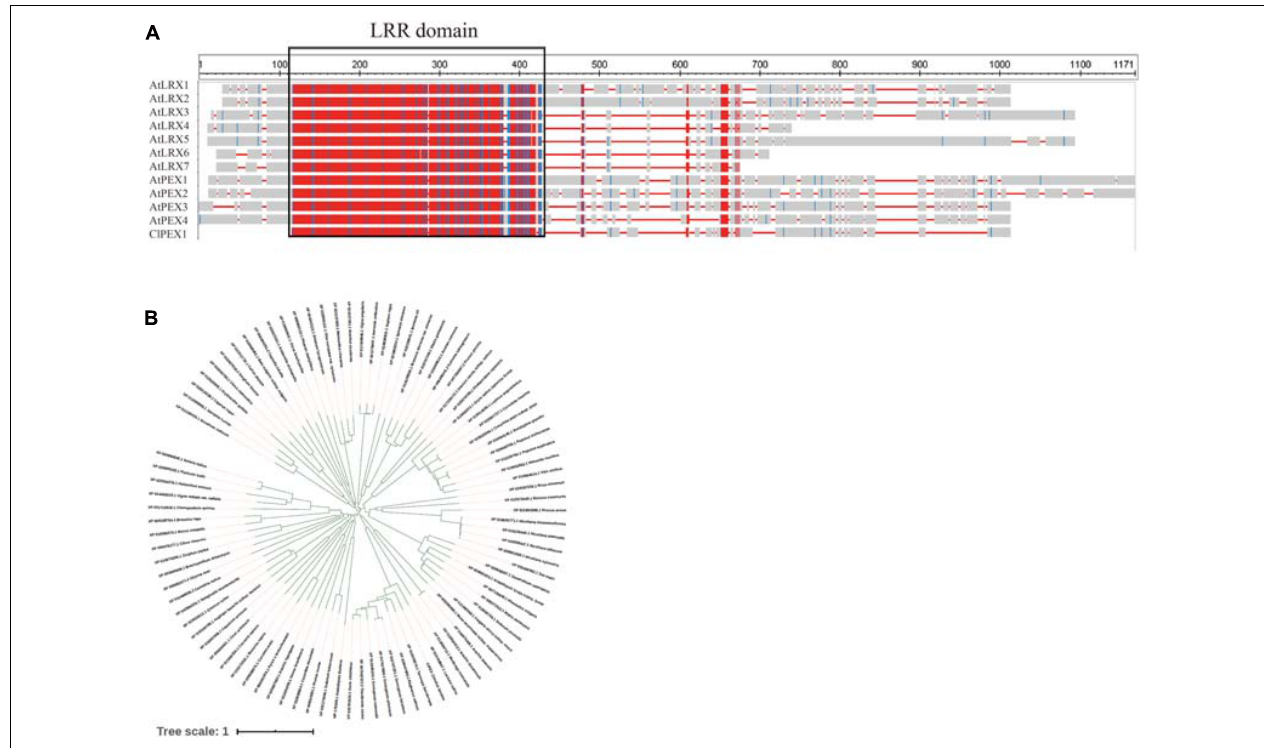
FIGURE 6 | Characterization of ClaPEX1 and its predicted product. (A) BLAST analysis of the pollen-specific leucine-rich repeat extensin-like protein 3 sequences in various organisms. The GenBank accession numbers of Arabidopsis thaliana genes are as follows: AtLRX1 (AY026364), AtLRX2 (AAF70841), AtLRX3 (CAB40769), AtLRX4 (BAB01951), AtLRX5 (CAB37452), AtLRX6 (BAB01255), AtLRX7 (NP_197937), AtPEX1 (BAB01698), AtPEX2 (AAD43152), AtPEX3 (AAD41978), and AtPEX4 (CAA19879). (B) Phylogenetic tree based on pollen-specific leucine-rich repeat extensin-like protein 3 sequences in different organisms. The GenBank accession numbers are provided. The sequences are in Supplementary Material .